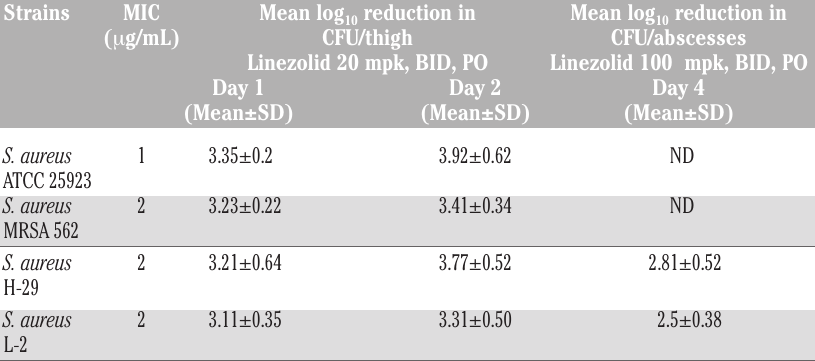
Table 1. Mean log reduction in cfu/thigh of S. aureus by linezolid in thigh and groin 10 infection studies.